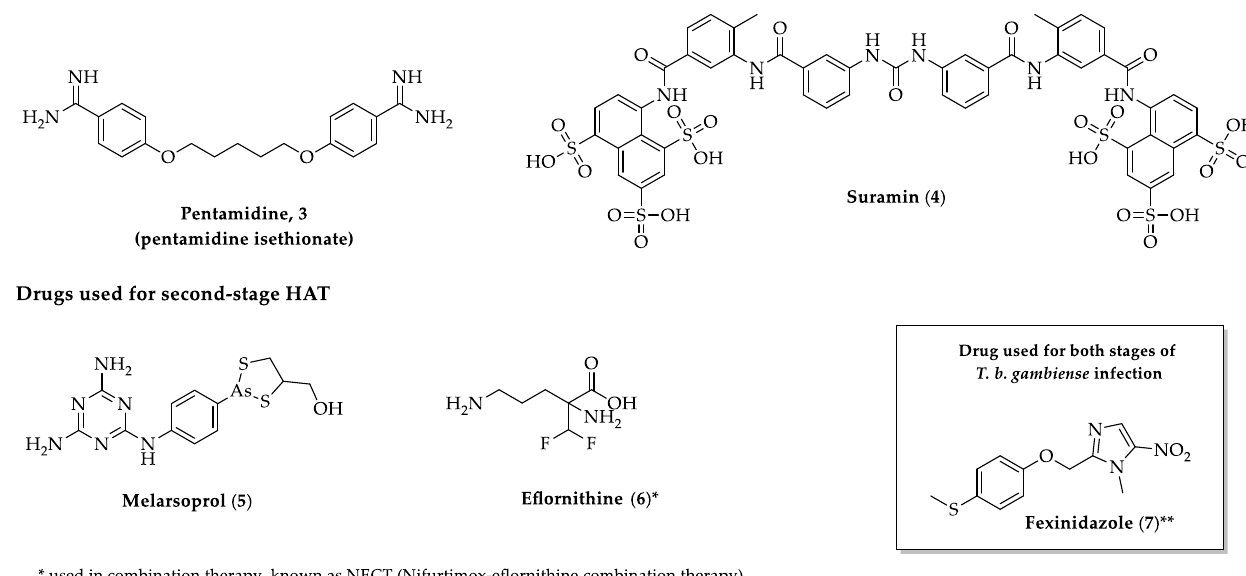
Figure 2. Approved drugs for human African trypanosomiasis (HAT) treatment.